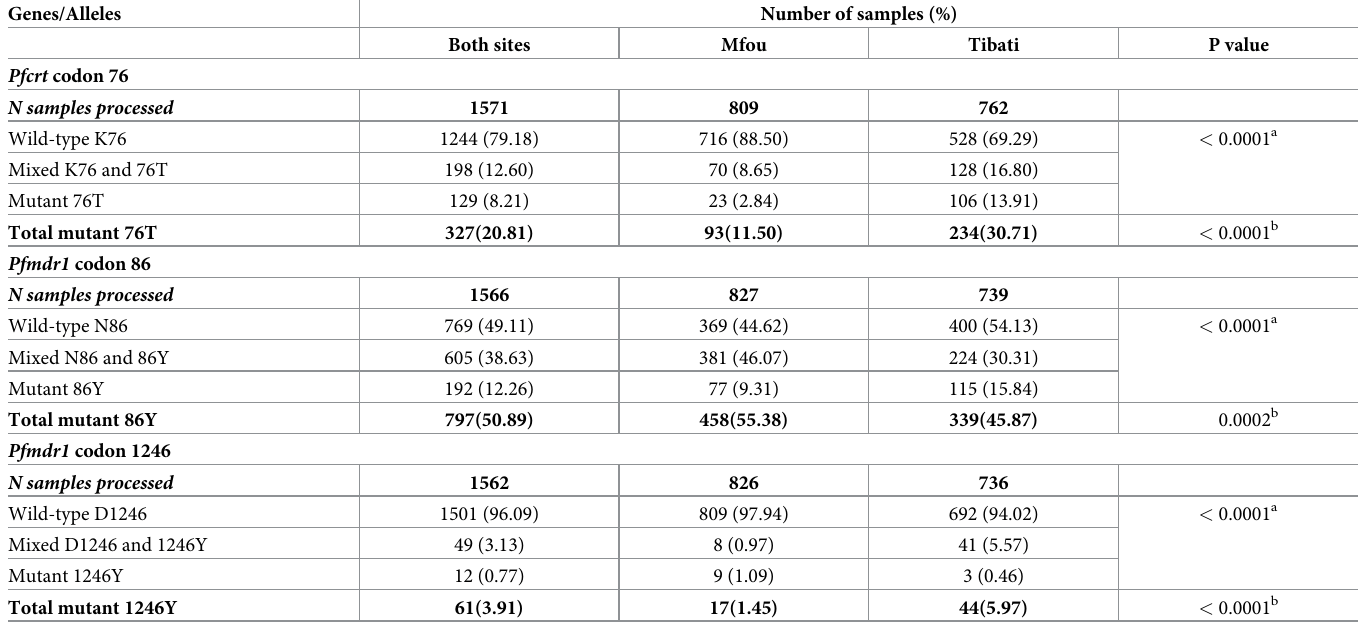
Table 3. Frequency of Pfcrt and Pfmdr1 genotypes in Plasmodium falciparum isolates from Mfou and Tibati, Cameroon.